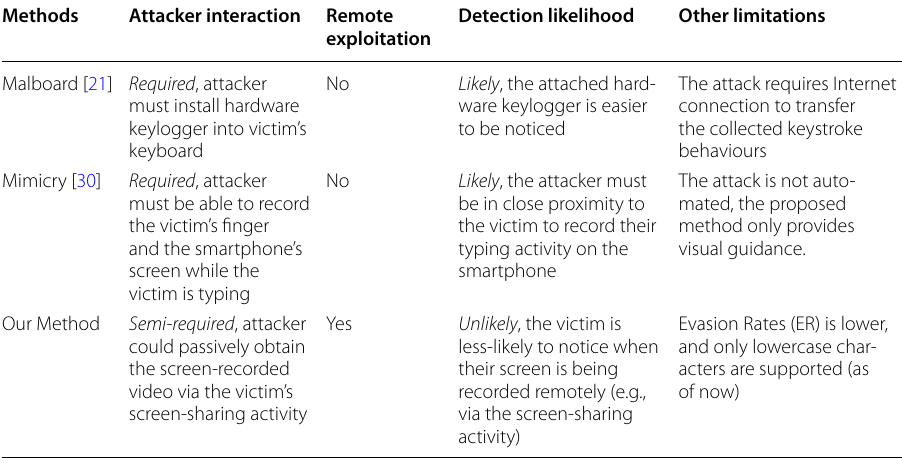
Table 10 Capability and limitations of some keystroke dynamics spoofing methods Methods Attacker interaction Remote Detection likelihood Other exploitation